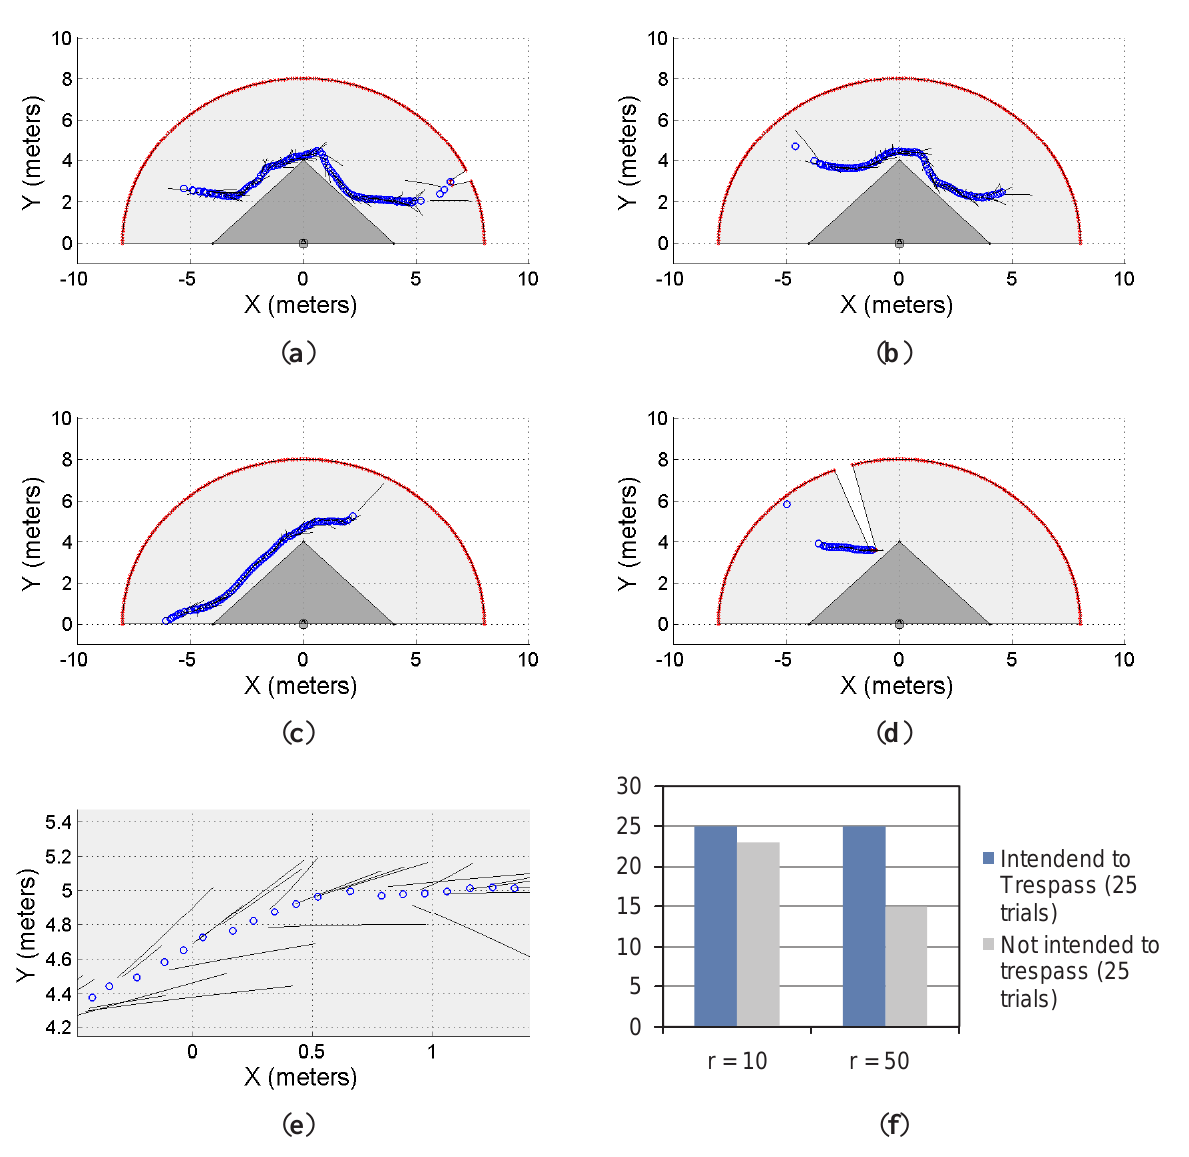
Figure 5. Single object prediction approach: first case. ( a – d ) different cases; ( e ) a close-up of the predicted movements; ( f ) the statistical results of the